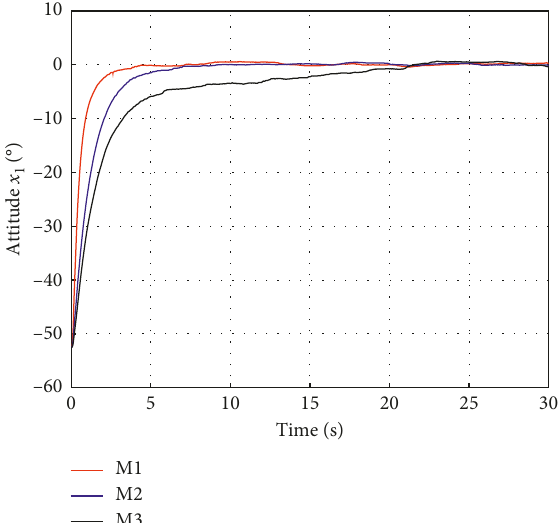
under the initial value 1